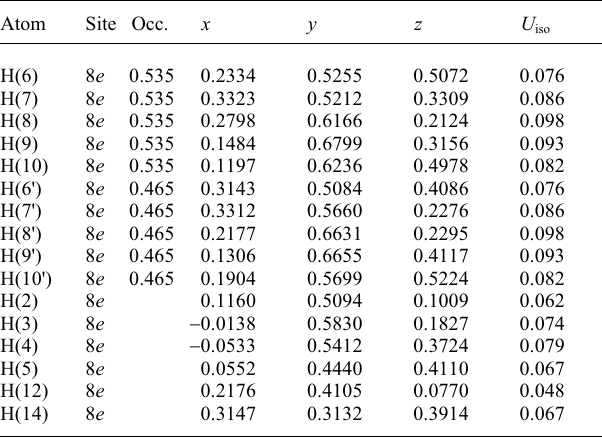
Table 2. Atomic coordinates and displacement parameters (in Å 2 )